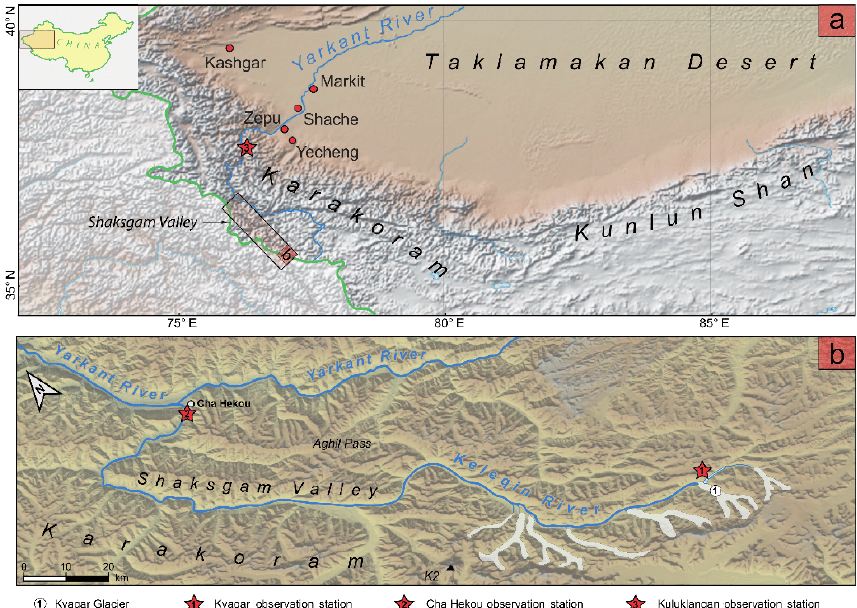
Figure 1. Location of (a) the Shaksgam Valley on the north side of the Karakoram Mountains in western China and (b) Kyagar Glacier in the Upper Shaksgam Valley. Observation stations at Kyagar Glacier, Cha Hekou, and Kuluklangan are indicated. The main flood impacts occur after the Yarkant River leaves the mountains near the Kuluklangan